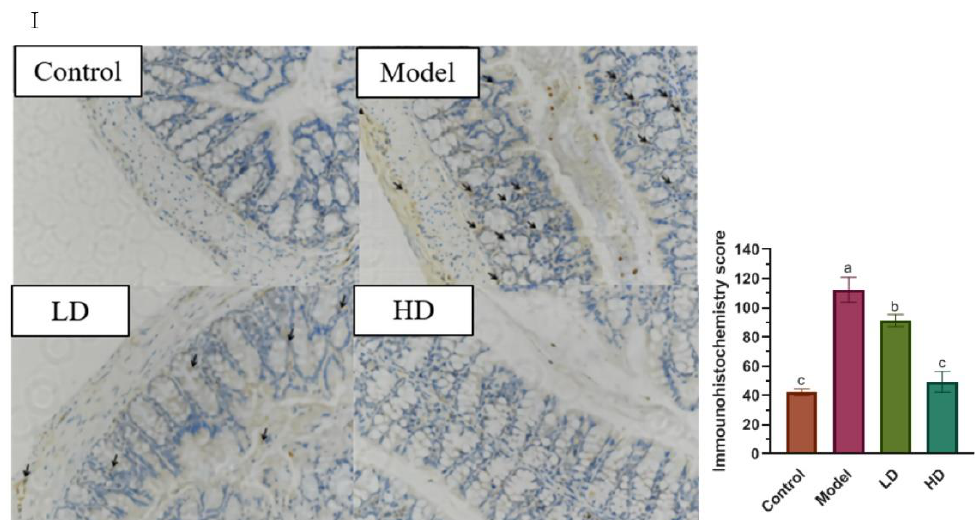
Figure 2. Effects of FBPE on colitis symptoms and colonic lesions, including body weight ( A ), food intake ( B ), disease activity index (DAI) ( C ), colon weights ( D ), typical images for length comparison of colon samples ( E ), spleen weights ( F ), typical images for swelling level comparison of spleen samples ( G ), H&E staining of colon sections and its semi-quantitative histological scoring ( H ), ICAM-1 immunohistochemical colon sections and score ( I ). Arrows represent the expression of ICAM-1. Different lower-case letters correspond to a significant difference of p < 0.05.